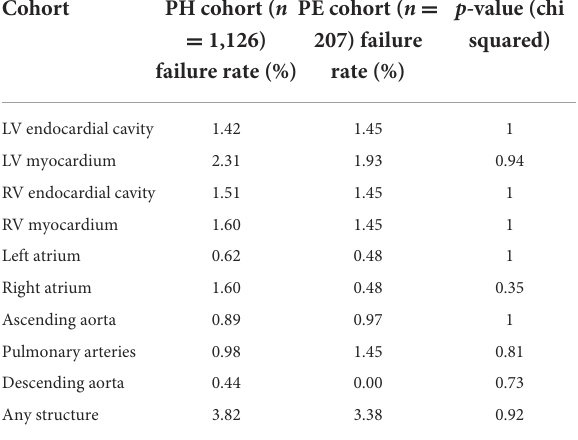
TABLE 6 Qualitative failure rates for DL model 2 in the pulmonary embolism (PE), and pulmonary hypertension (PH) cohorts.